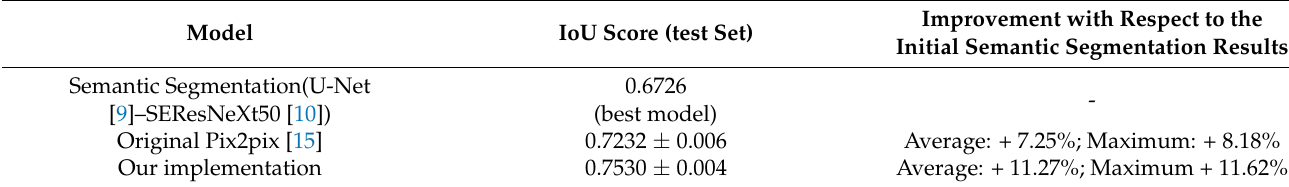
Improvement with Respect to the Initial Semantic Segmentation Results